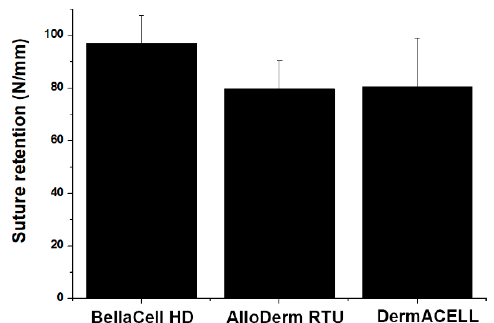
Figure 6. Suture retention strength test. Four samples (2 cm × 4 cm) were prepared from each ADM. From the bottom of the sample, a suture was passed through the ADM (1.0 cm). A pulling rate of 20 mm / min was applied as the suture tore out of the ADMs. The maximum load (N) was recorded as mean ± SEM. It displays the maximum load of 97.06 N, 79.65 N, and 80.48 N for BellaCell HD, AlloDerm RTU, and DermACELL, respectively. Each datum represents the ± SEM of three independent experiments.